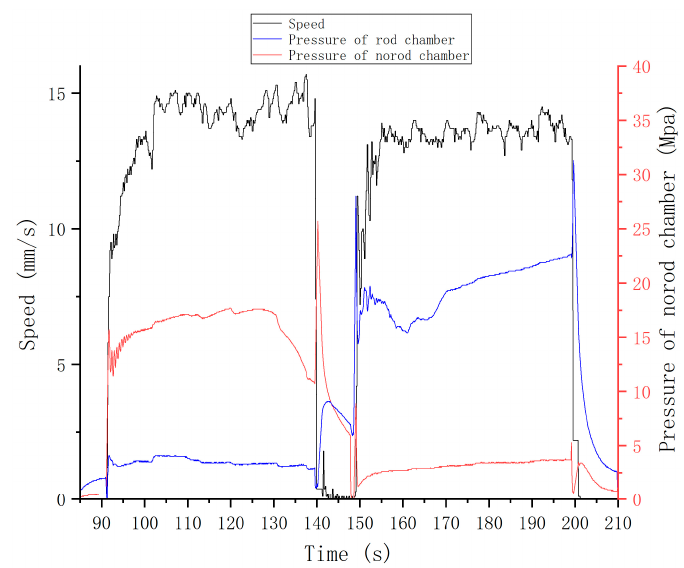
Figure 30. Step response experiment results of cylinder #6 using PID.